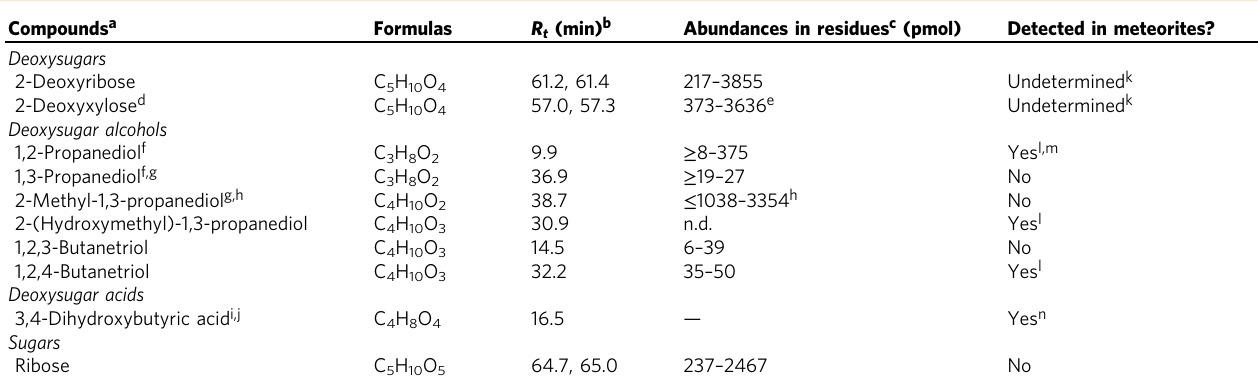
Table 1 Deoxysugar derivatives identi fi ed in the ice photolysis residues (regular and 13 C-labeled) Compounds